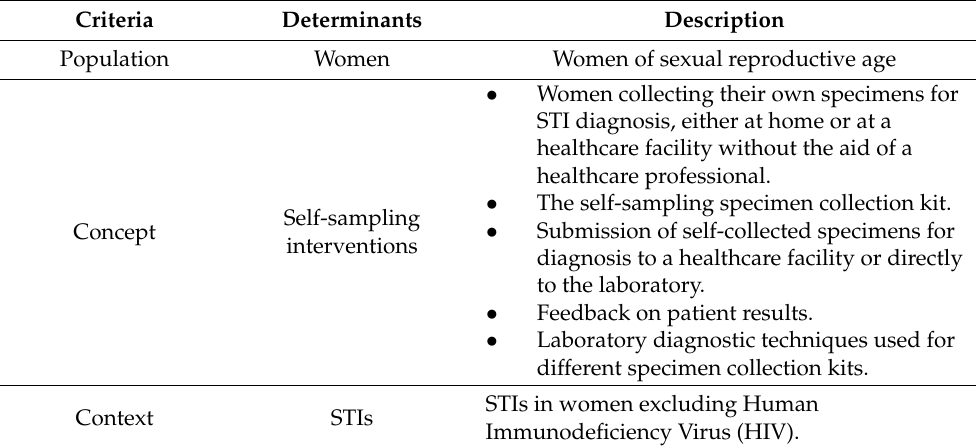
Table 1. PCC framework for defining eligibility of studies to address the research